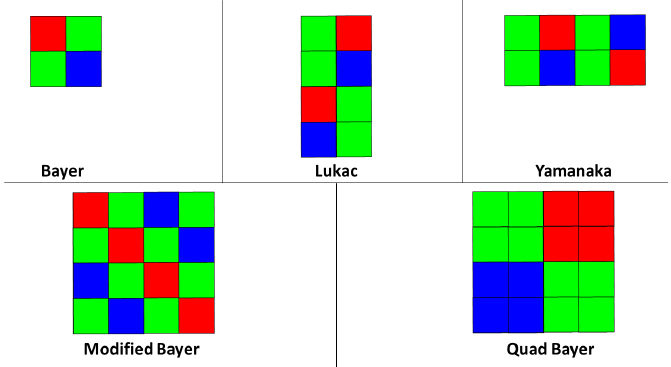
Figure 4. Bayer-like CFA patterns used in the experimental analysis: Bayer, Lukac, Yamanaka, Modified Bayer and Quad